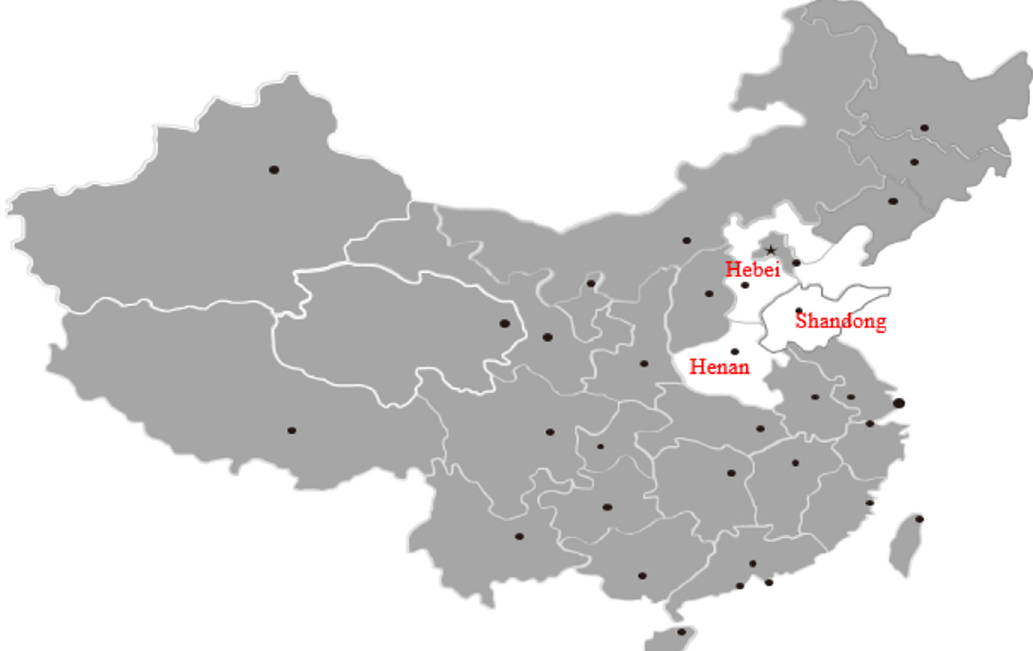
Figure 1. Map of China showing the geographical regions of Hebei, Henan and Shandong provinces where donkeys were